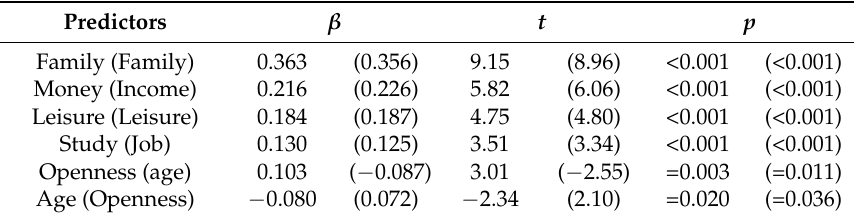
Table 13. Standardized regression coefficient ( β ), t -value, and p -value for predictors of overall satisfaction score for Survey